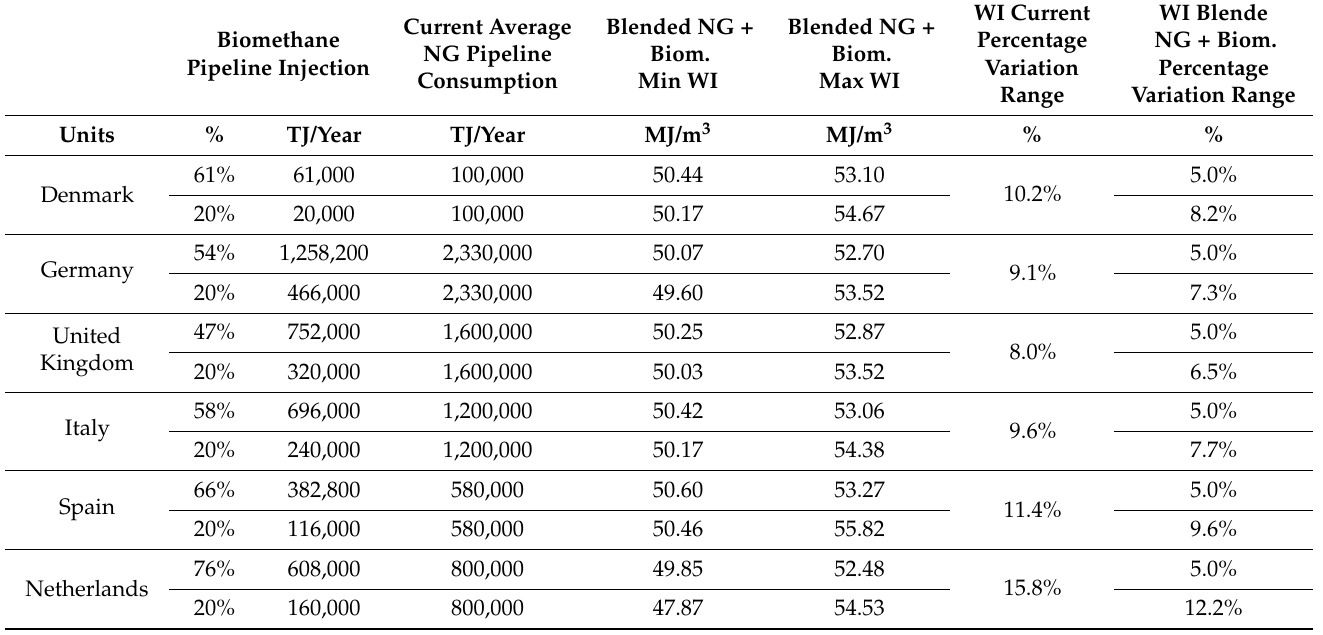
Table 6. Fossil natural gas mixed with biomethane—WI